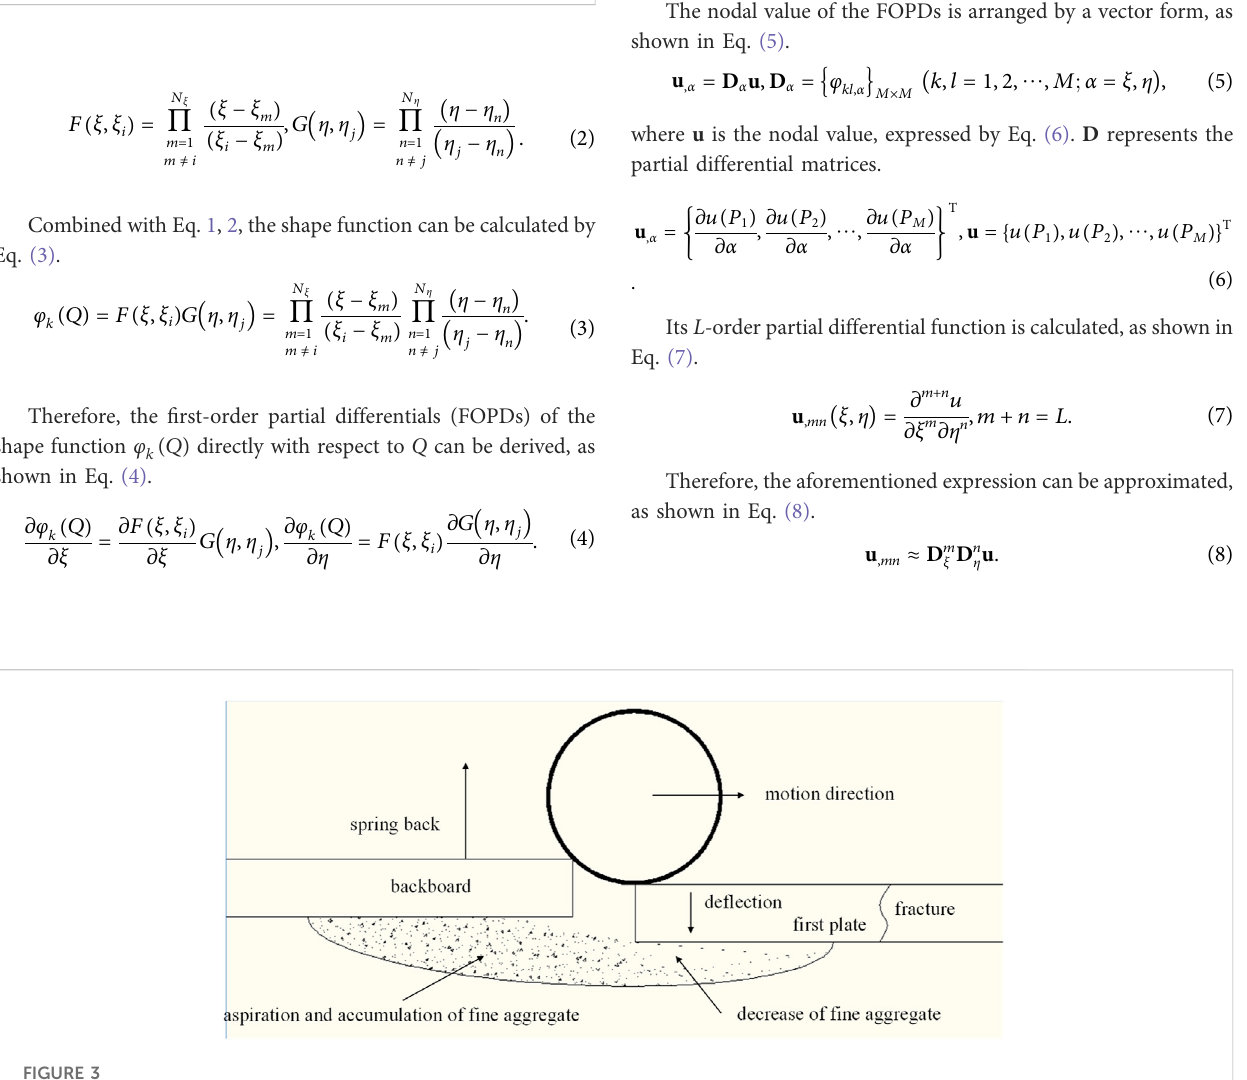
FIGURE 2 Starting and ending angles for block q at joint O.